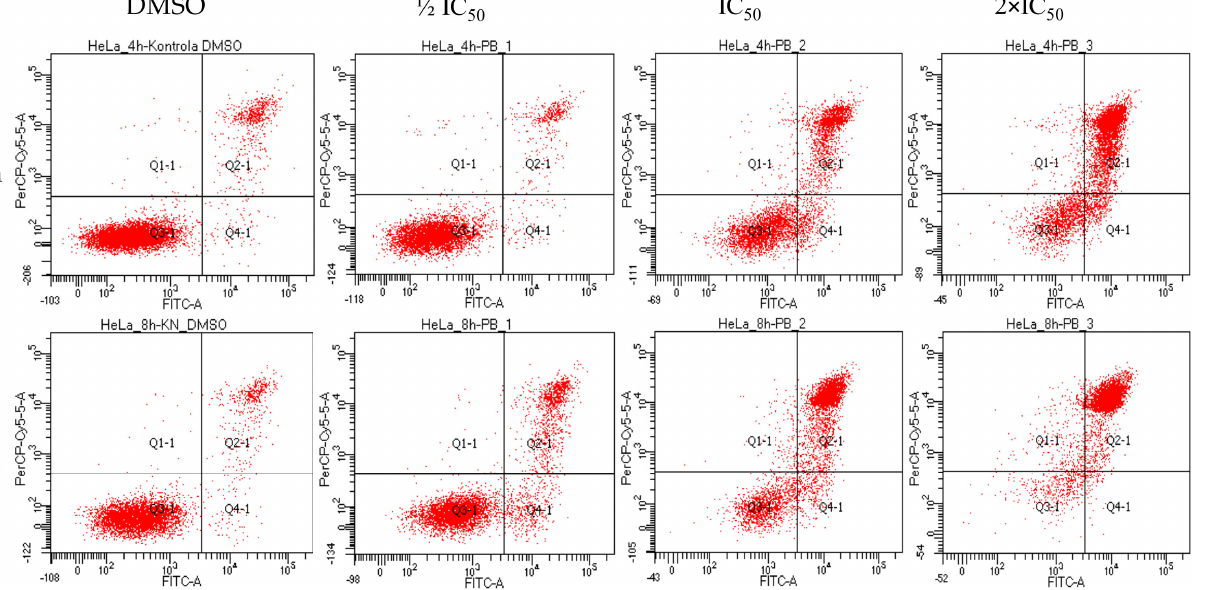
Figure 12. Representative flow cytograms were obtained by double staining Annexin V (FITC) and propidium iodide (PI). Characteristic time and dose ‐ dependent shift of HeLa cells population from An ‐ PI ‐ (lower left quadrant) to An + PI + (upper right quadrant) progress through An + PI ‐ state (lower right quadrant) at each cytogram, respectively. Studied concentrations were related to IC 50 result of 24 h cytotoxicity assay (1/2 IC 50 –2.83 μ g/mL, IC 50 –5.66 μ g/mL, 2 × IC 50 –11.32 μ g/mL, DMSO–0.4%).